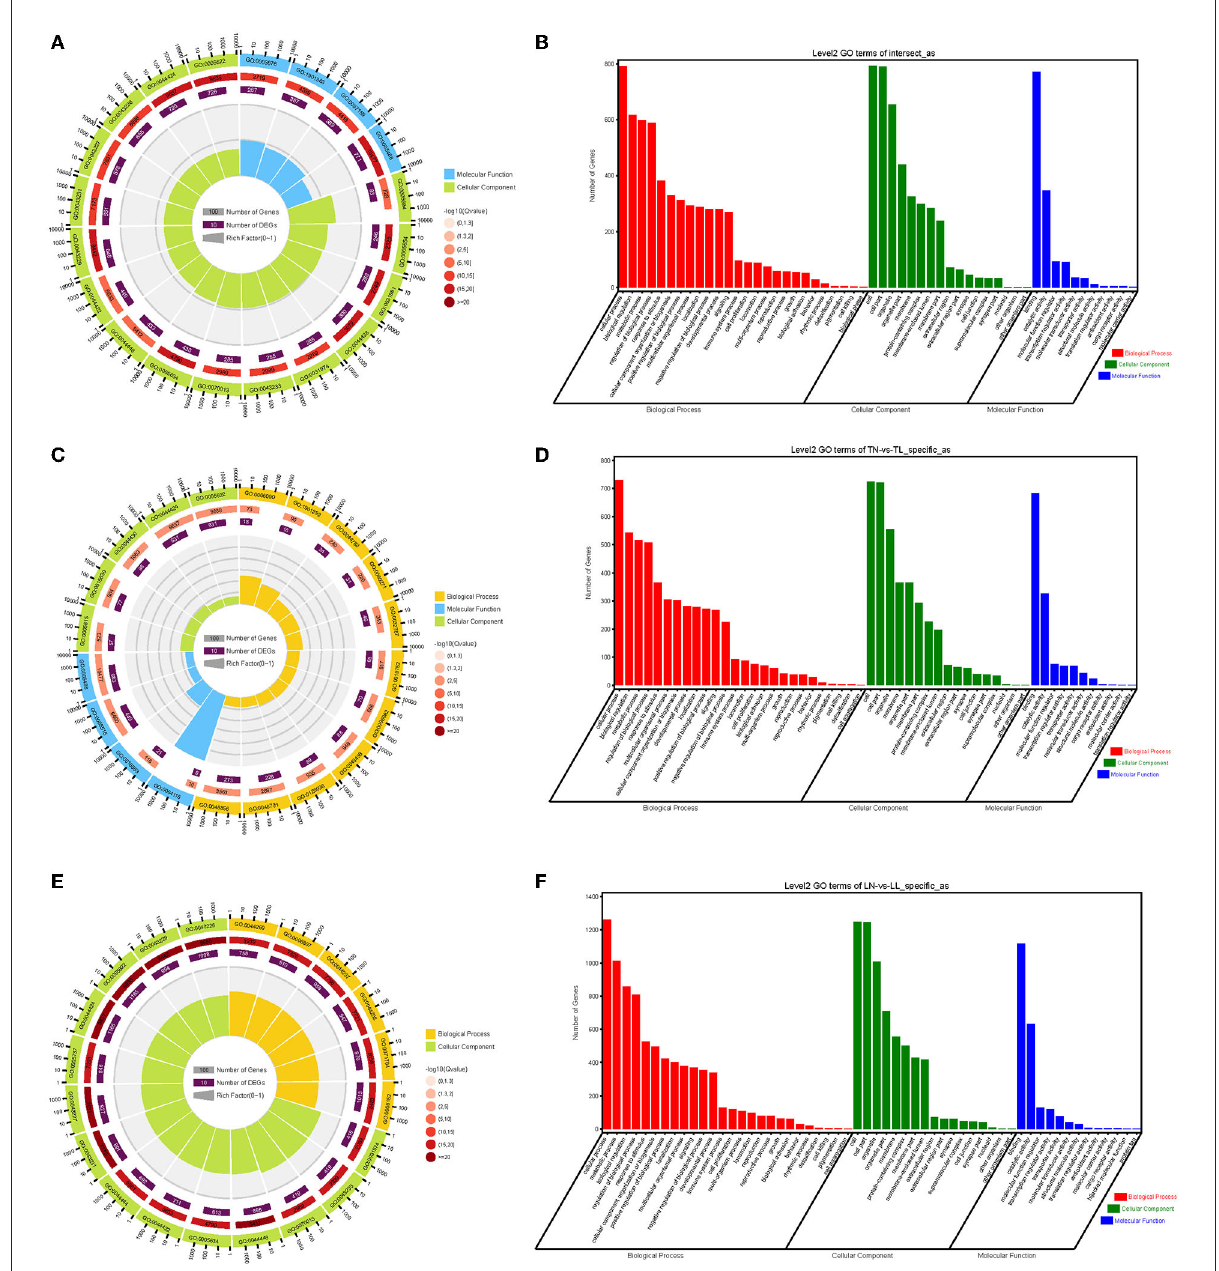
FIGURE4 GO functional annotation (A,B) between normoxic (TN and LN) and hypoxic (TL and LL) groups, (C,D) between TN and TL (excluding alternatively spliced DEGs shared between normoxia and hypoxia groups), and (E,F) between LN and LL (excluding alternatively spliced DEGs shared between normoxia and hypoxia groups)